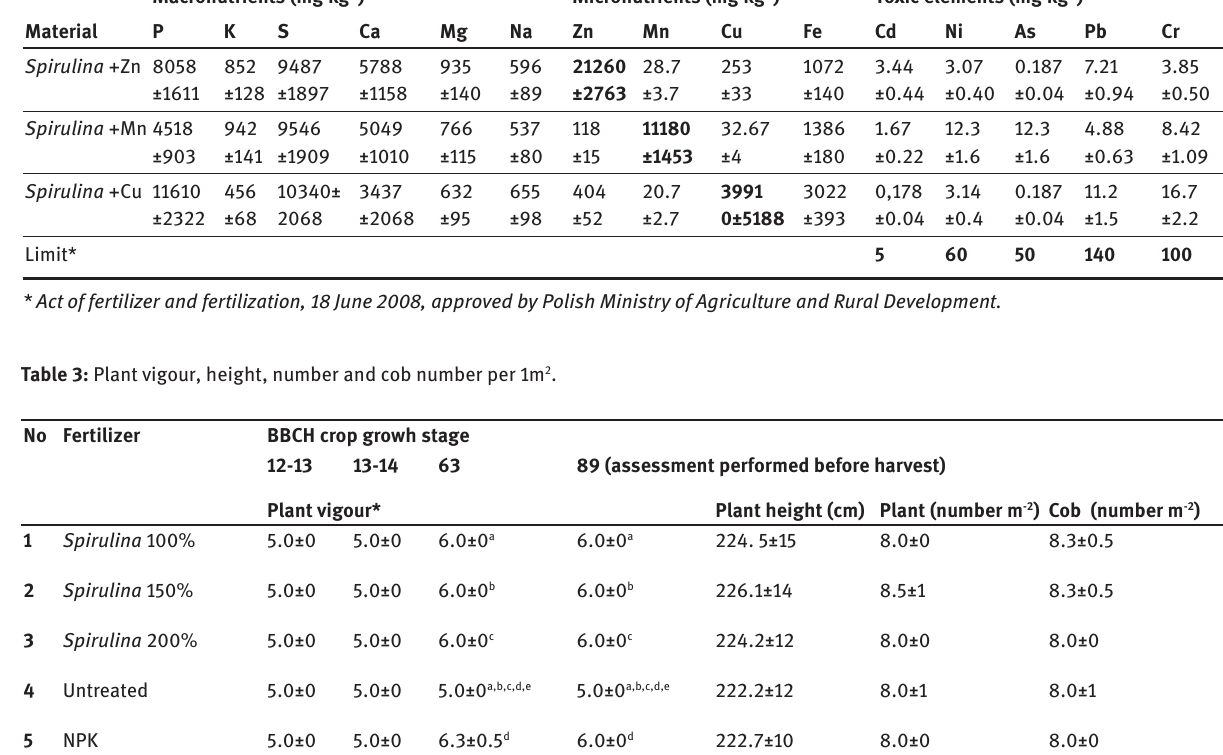
Table 2: Multielement content of new biocomponents.